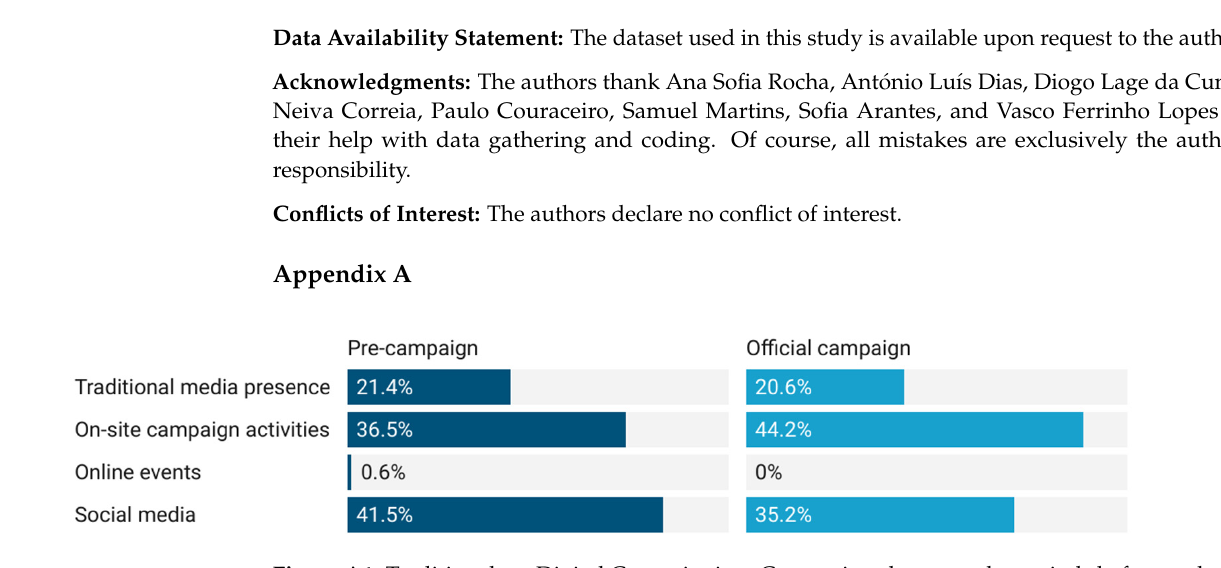
Figure A1. Traditional vs. Digital Campaigning. Comparison between the periods before and after the beginning of the official campaign (2016 election). Source: Own data (see Section 3.1.1).